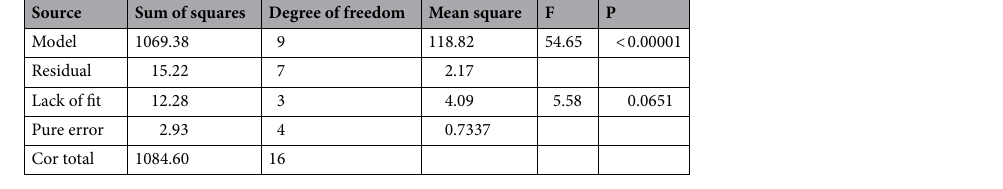
Table 3. Analysis-of-variance